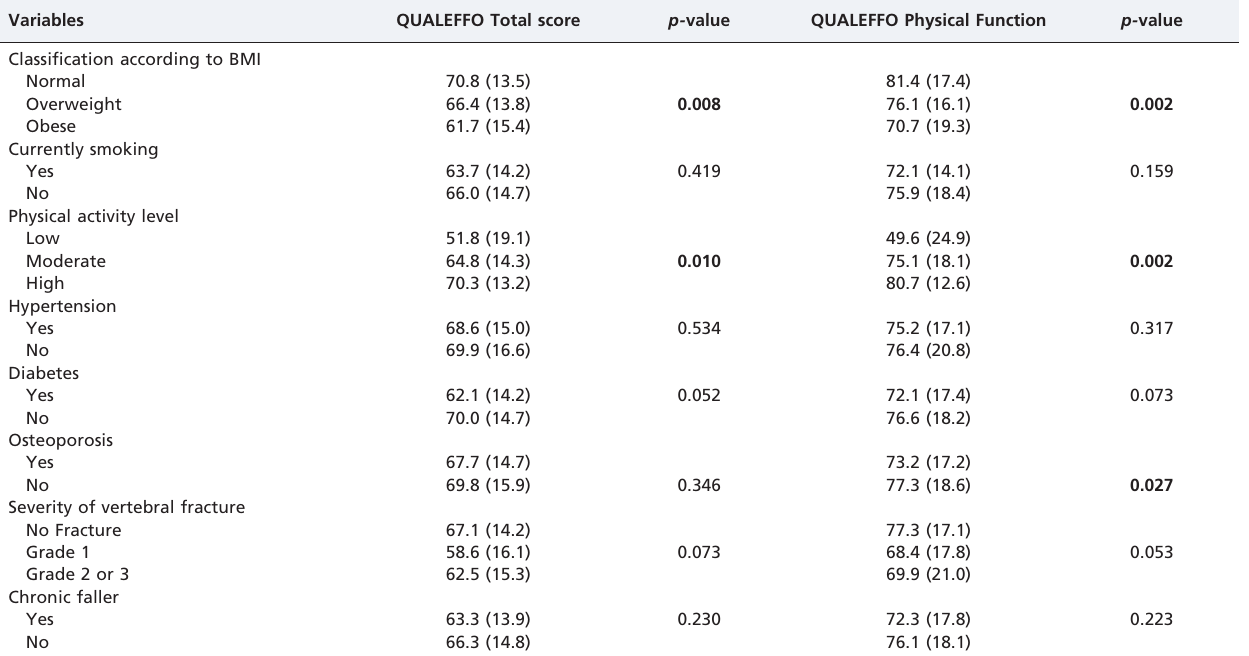
Table 3 - Association between categorical variables and the quality of life questionnaire scores (QUALEFFO: Total score and physical function domain score).